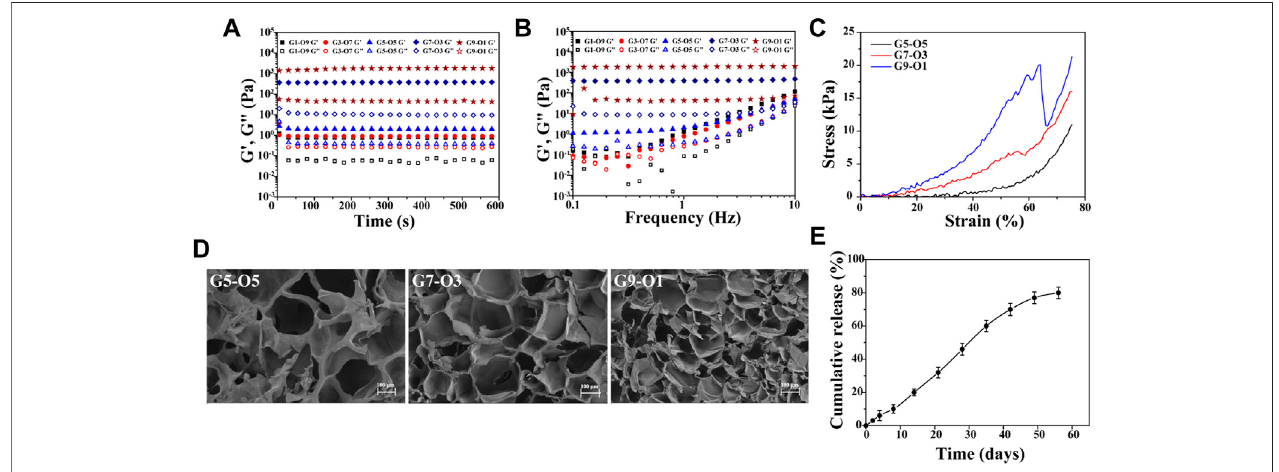
FIGURE 2 | (A) Time-sweep sequence and (B) frequency sweep of hydrogel with different mass ratio; (C) strain-stress curve of G5-O5, G7-O3, and G9-O1 hydrogel; (D) SEM images of cross-sections of three hydrogels. (E) Release curve of KGN obtained from GelMA/ODex/SMNP-KGN